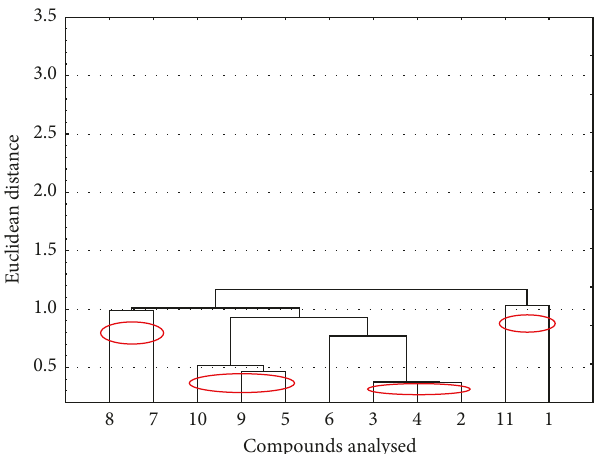
Figure 2: Similarity analysis for compounds investigated based on their values of lipophilicity.